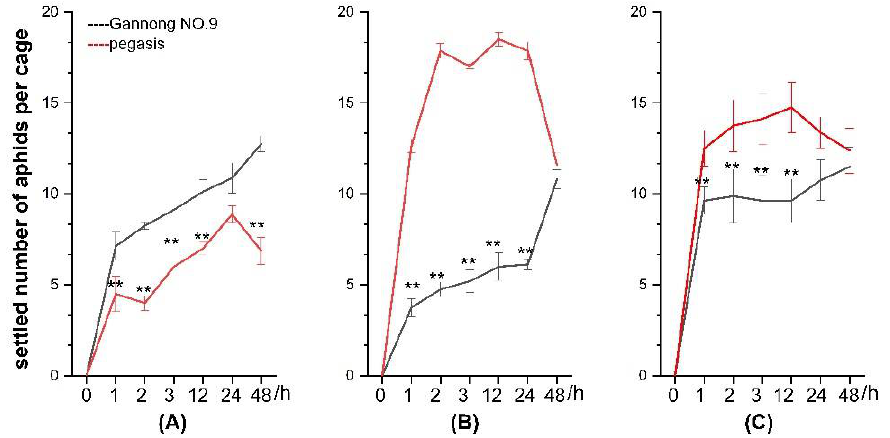
Figure 4. Number of ( A ) cowpea aphid (CPA), ( B ) pea aphid (PA), ( C ) spotted aphid (SAA) released and settled on the alfalfa cultivars of Pegasis and Gannong NO.9 at 1, 2, 3, 12, 24, 48 h (** Indicates that the difference is significant, p < 0.05).